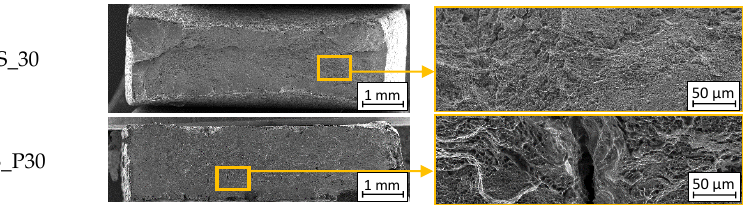
Figure 6. Fracture surfaces of samples after tensile tests with marked inter-crystalline cracks areas. Arrows mark the locations of occurrence of cracks near the pores of the material. The faults visible were caused by the inter-crystalline cracking process (Figure 6).